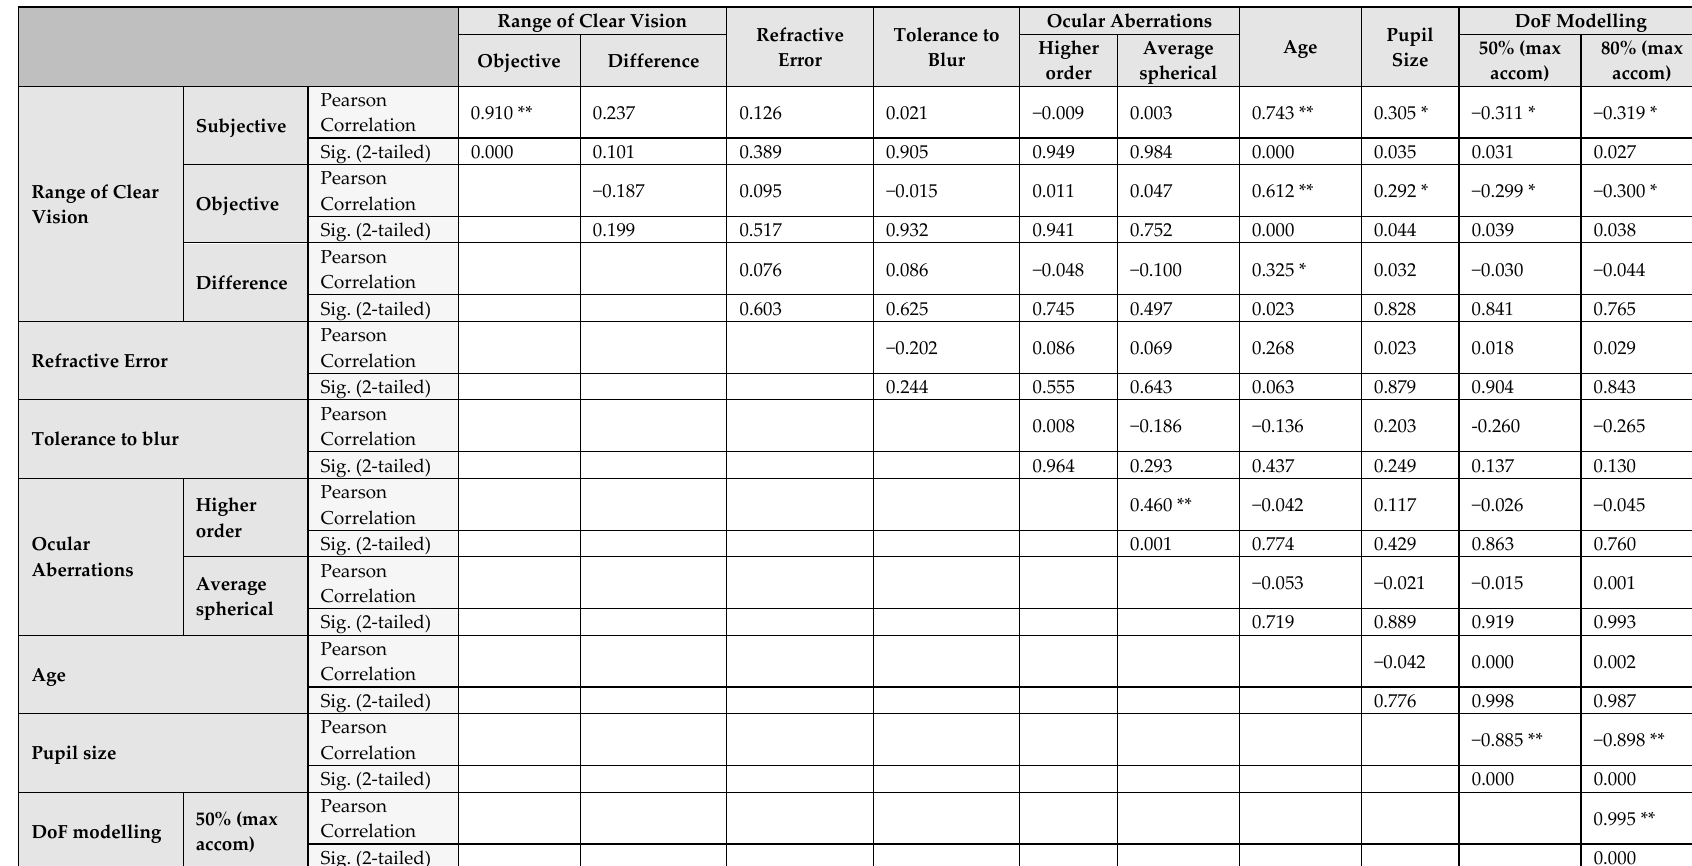
Table 1. Relationship (Pearson’s correlation) between subjective and objective range of clear focus and age, pupil diameter, tolerance to blur, ocular aberrations and depth of focus modelling at maximum accommodation. n = 50. * indicates 2-tailed significance at p < 0.05 and ** at p < 0.01.